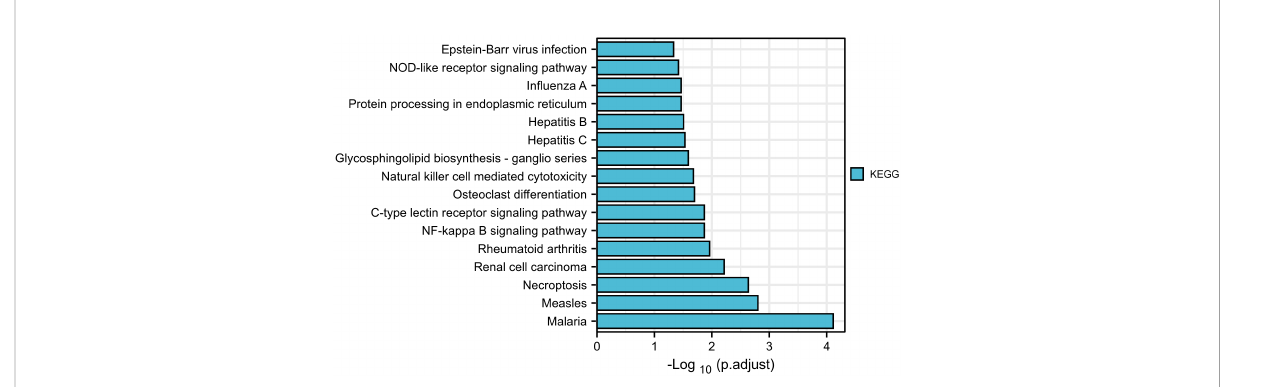
FIGURE 5 KEGGenrichment analysisofSLFNgenefamily. KEGGenrichmentanalysissuggestedthatSLFNfamily wasassociated withinfectiousandin fl ammatory diseases, includingmalaria, measles, rheumatoidarthritis, Epstein-Barrvirusinfection, hepatitis B, hepatitisC, etc. TheNF-kBsignalpathway are related.